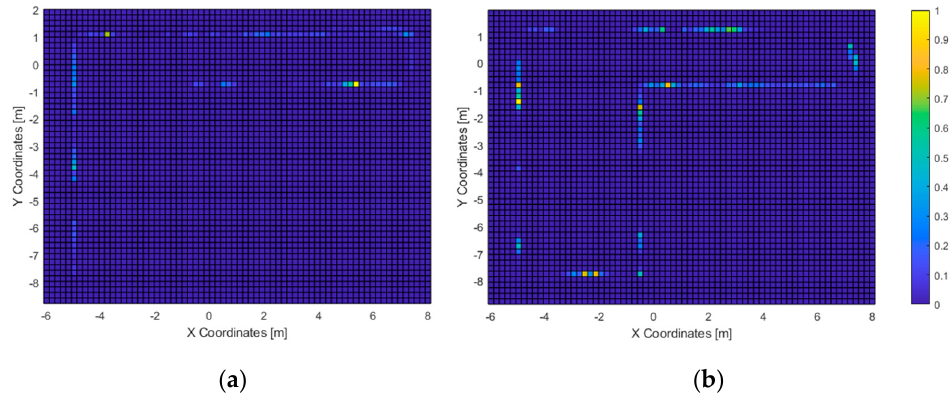
Figure 15. Test 2—Haptic heatmaps of those who passed the test ( a ) and those who did not ( b ).